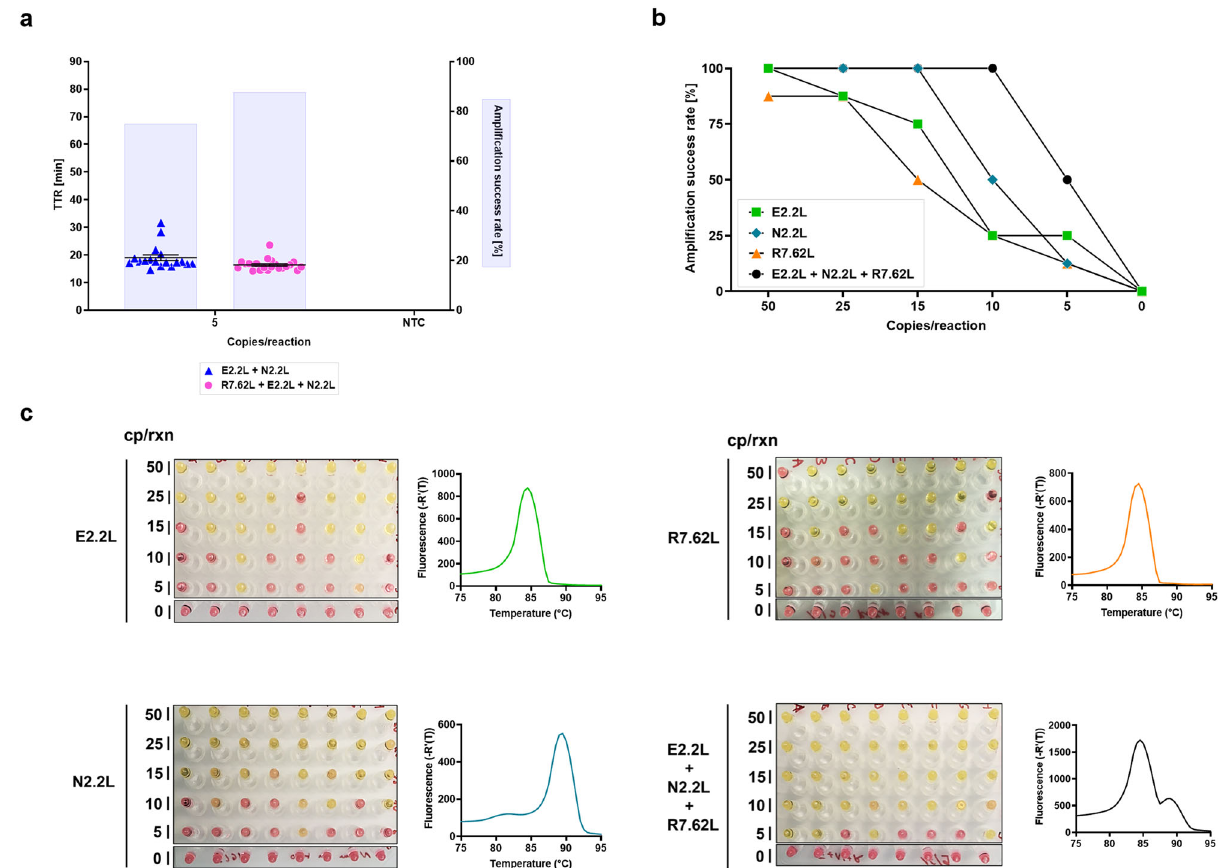
Fig. 3 Primer set triplexing with RdRP gene detection and its impact on sensitivity. a Comparison of duplexed (E2.2L + N2.2 L) and triplexed (E2.2 L + N2.2L + R7.62 L) primer sets at sub-limit of detection amounts of RNA template input. n = 24 technical replicates per group were used. b , c Analytical limit of detection experiment with triplexed combination of E2.2 L + N2.2 L + R7.62 L primer sets compared to individual primer sets. Experiments were run for 45 min and were evaluated by colorimetric detection only. Open symbols represent non-speci fi c products, whereas closed symbols are speci fi c as determined by melt curve analysis of ampli fi cation products. The highest time to reaction value on y-axis signi fi es the total duration of the reaction. Ampli fi cation success rate shows the percentage of samples that ampli fi ed over the course of the reaction. For NTC reactions, PCR-grade water was used as the input. All experiments were performed using the “ NEB WarmStart 1.2 ” reaction mix. Error bars represent standard error of the mean. TTR time to reaction, NTC no-template control, cp/rxn copies per